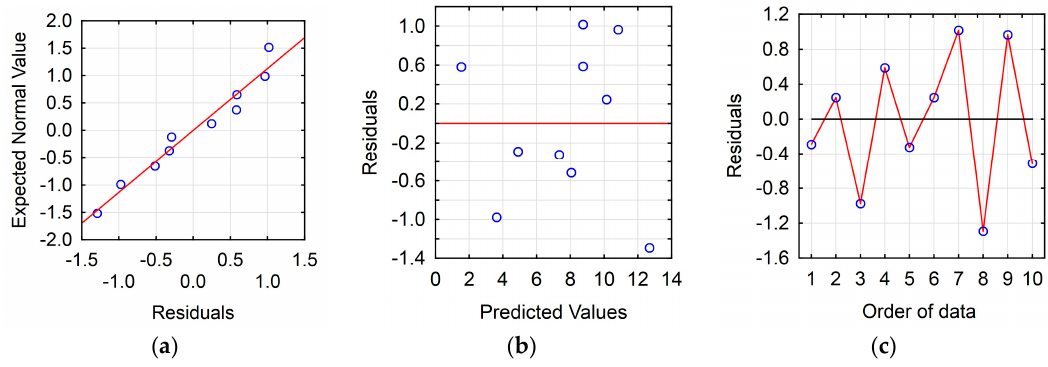
Figure 4. Plots for the check model of the arithmetic mean of the deviations from the mean Sa : ( a ) the normal plot of residuals; ( b ) the residuals versus the predicted values; and ( c ) the residuals versus the order of the data.